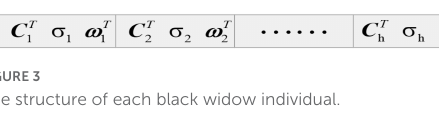
FIGURE3 The structure of each black widow